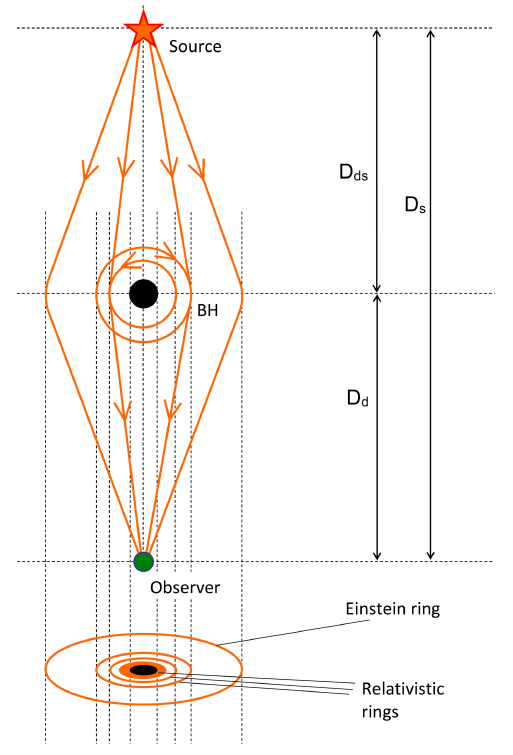
Figure 5. Scheme of formation of Einstein ring and relativistic rings by black hole